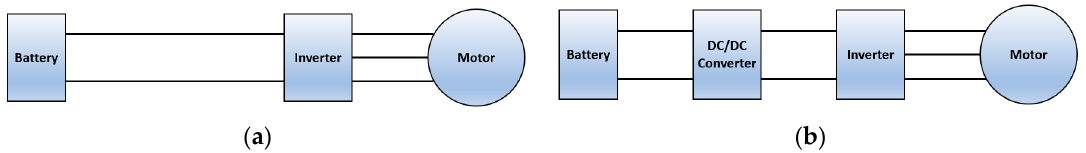
Figure 1. Powertrains for electric vehicles: ( a ) Non-chopper powertrain; ( b ) Series-chopper-based powertrain [7] .